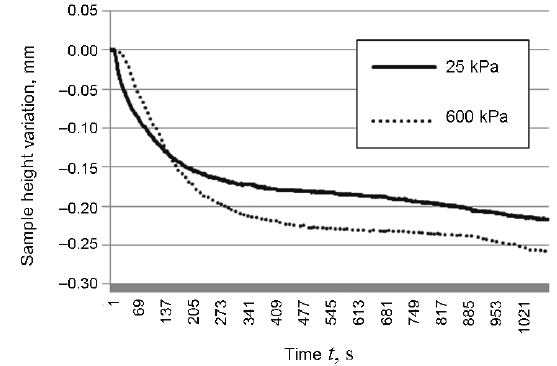
Fig. 8. The angle of internal friction versus the quantity of tests